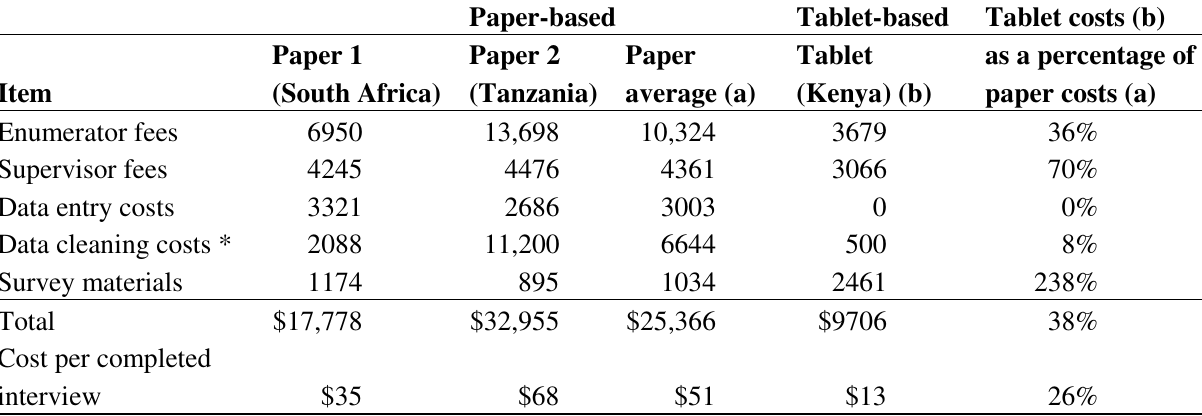
Table 1. Cost comparison of paper-based versus tablet-based survey data collection (in 2011 purchasing power parity (PPP) US$) showing tablet costs as a percentage of paper costs and the cost per completed